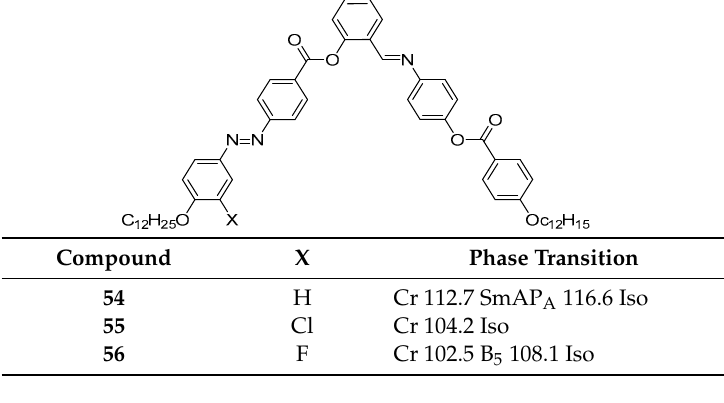
Table 11. Phase transition of V-shaped compounds 54–56 .